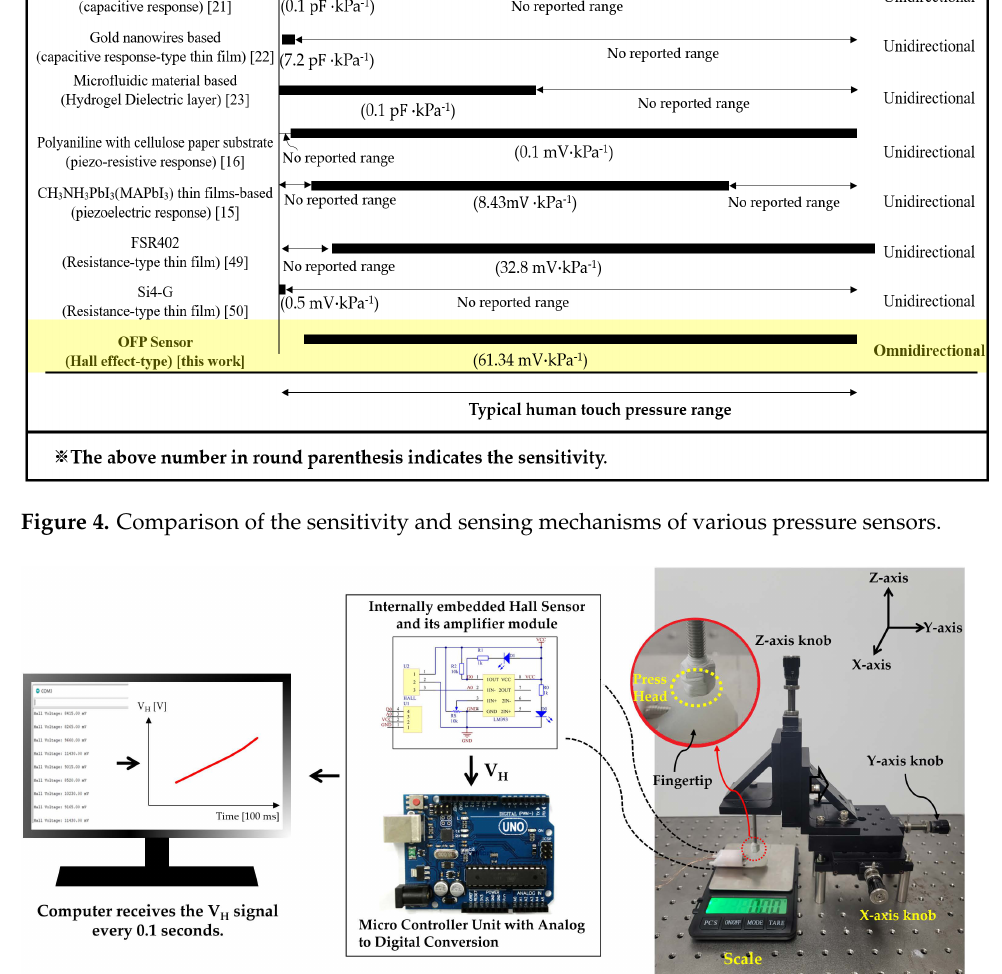
Figure 5. Measurement setup of the OFP sensor using the three-axis moving stage, where the press head contact area with the fingertip surface is 10 (cid:2870) mm (cid:2870) .